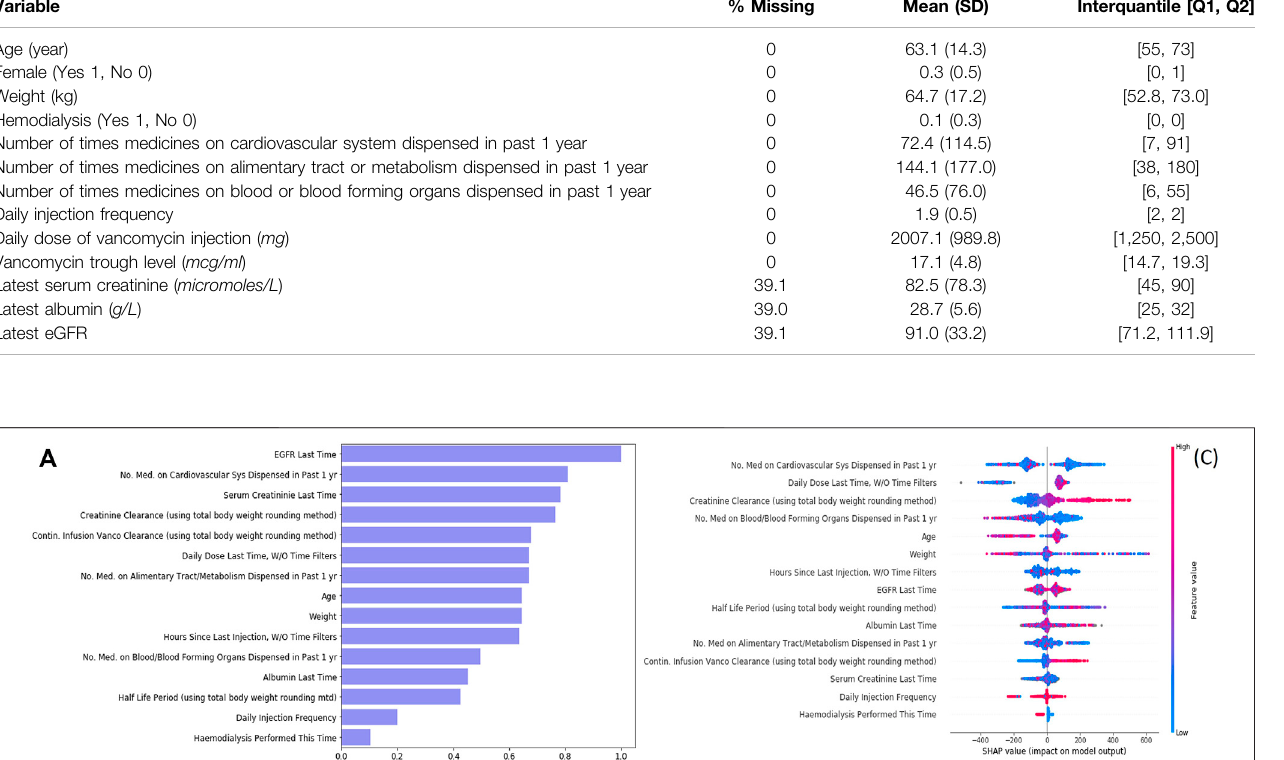
Frontiers in Pharmacology |